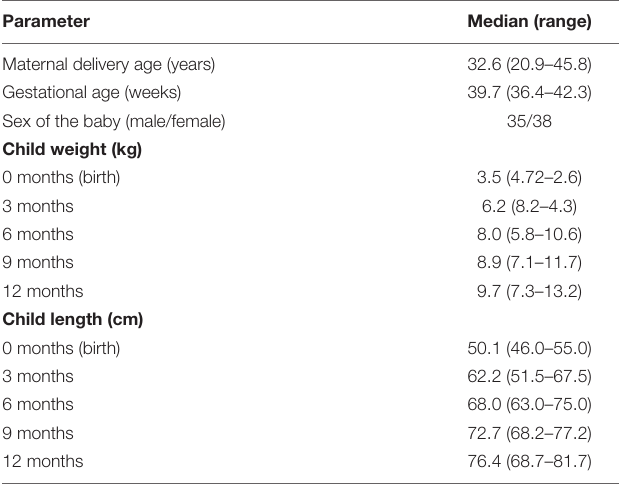
TABLE 1 | Demographic characteristics of the study population.